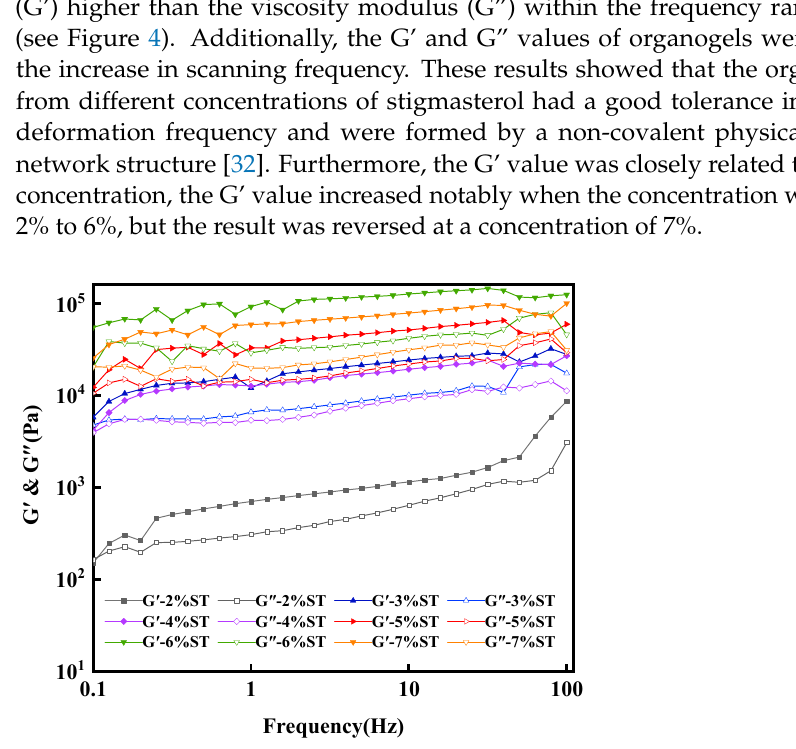
centration of 2–6%. This result indicates that the organogels showed a viscous behavior at high temperatures in a completely molten state. The critical phase transition temperature increased prominently from 45 °C to 95 °C with the increasing concentration. However, the absence of the critical phase transition temperature was found in the organogels at a 7% stigmasterol concentration, which showed the organogels did not undergo a gel-sol transformation [37]. Therefore, the organogels have high thermal stability with a 7% stig- masterol concentration. This may be because the number of crystals was increased with